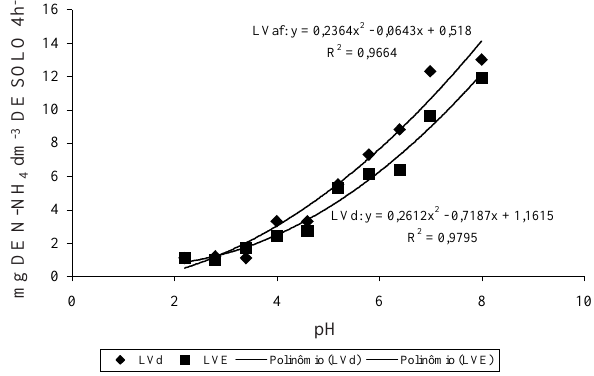
Figura 4. Velocidade de hidrólise da uréia (mg de N-HH dm -3 de solo 4 h -1 ), sob influência do pH, 4 em amostras de Latossolo Vermelho Alumino- férrico típico e Latossolo Vermelho distrófico